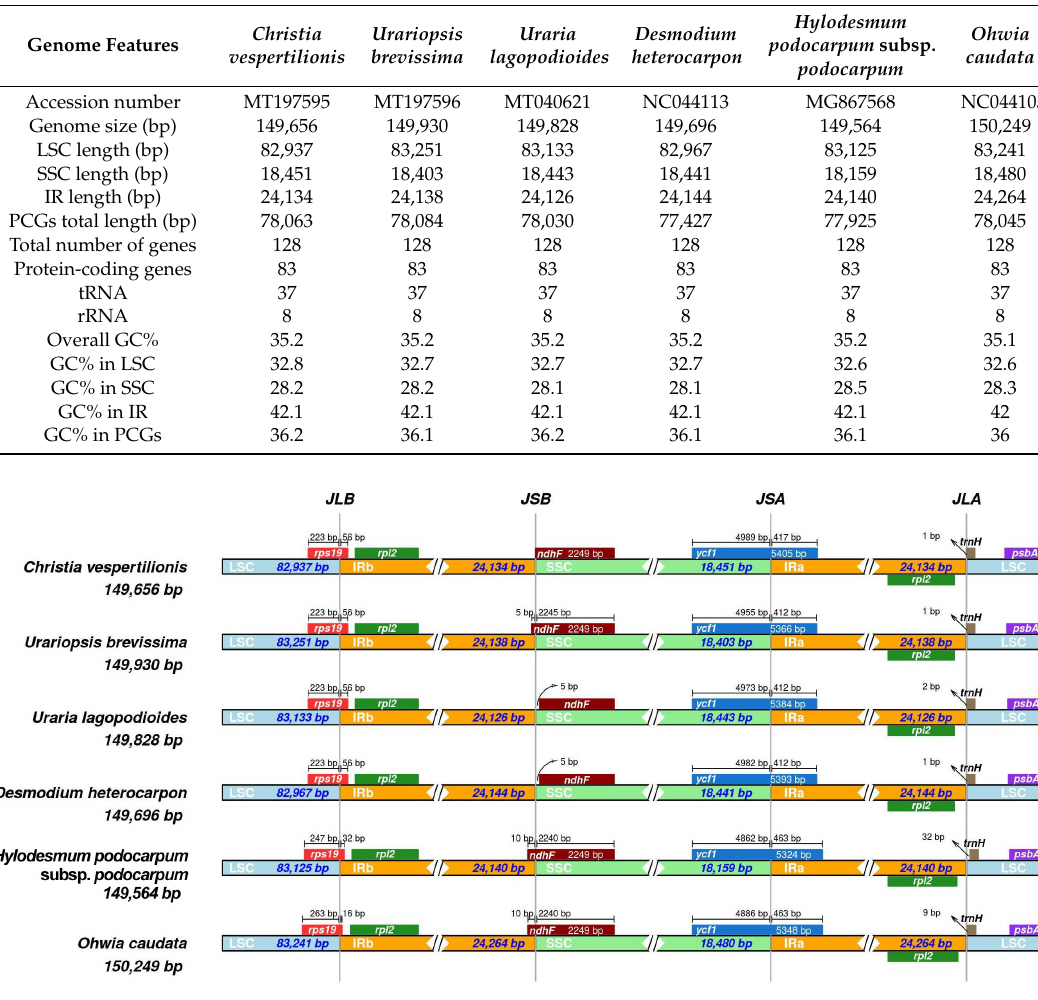
Figure 2. Comparison of the border position of LSC, IR and SSC among chloroplast genomes of six Desmodieae